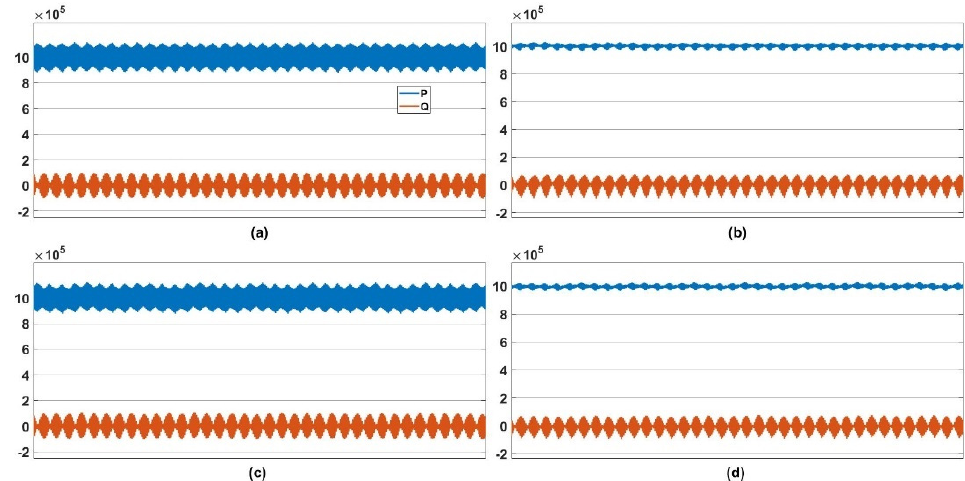
Figure 15. Power flow in the case of ( a ) 2L- αβ , ( b ) 3L- αβ , ( c ) 2L-dq and ( d ) 3L-dq.